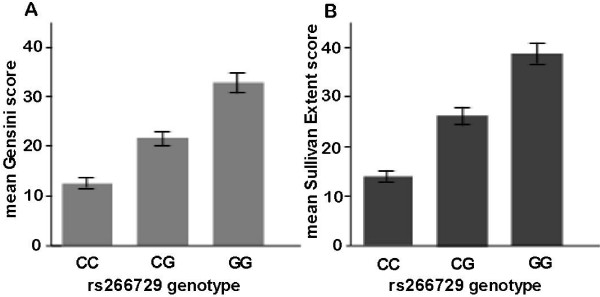
Coronary artery disease severity by rs266729 genotype. CAD severity is illustrated here as (A) the unadjusted geometric mean of Gensini score (P < 0.001) and (B) the unadjusted geometric mean of Sullivan Extent score (P < 0.001). The error bar shows the 95% CI of the geometric mean.